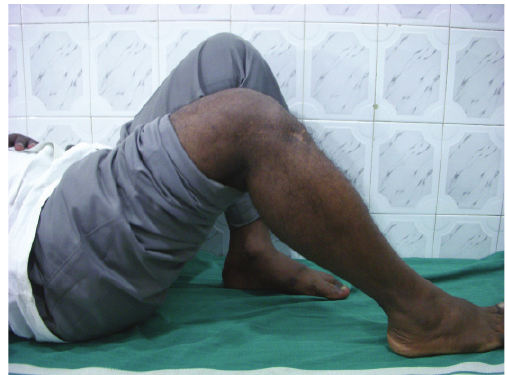
Figure 10: Clinical picture at 2-years followup after figure of 8 wire removal showing knee flexion up to 100 ◦